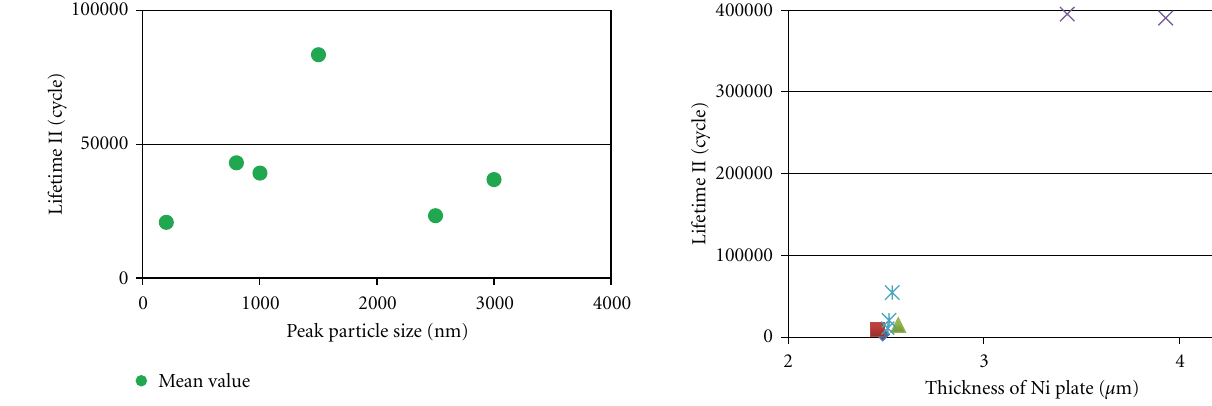
Figure 12: E ff ect of peak particle size in electrolytes.